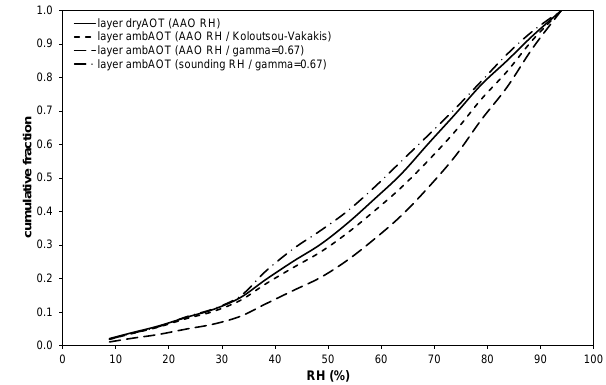
Fig. 10. Cumulative fraction of the AAO aerosol optical thickness for each flight level adjusted to low RH measured by the AAO RH sensor, the AAO aerosol optical thickness for each flight level ad- justed to the ambient RH measured by the AAO RH sensor us- ing both Koloutsou-Vakakis et al. (2001) ( γ =0.33) and Quinn et al. (2005) ( γ =0.67) parameterizations, and the AAO aerosol opti- cal thickness for each flight level adjusted to the ambient RH mea- sured by the atmospheric sounding using Quinn et al. (2005) param- eterization ( γ